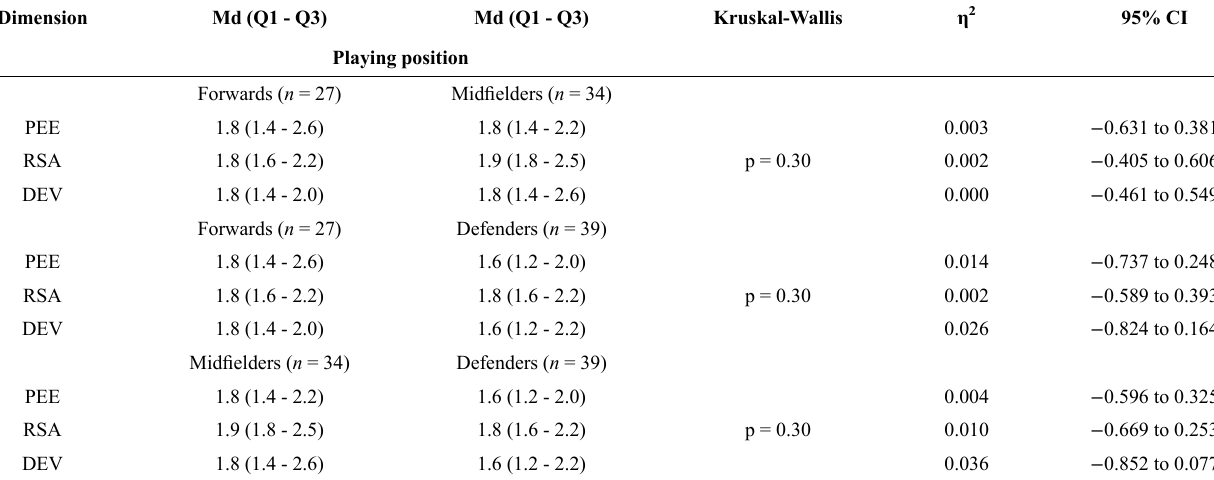
Table 2 - The perception of burnout dimensions by playing positions. Dimension Md (Q1 -